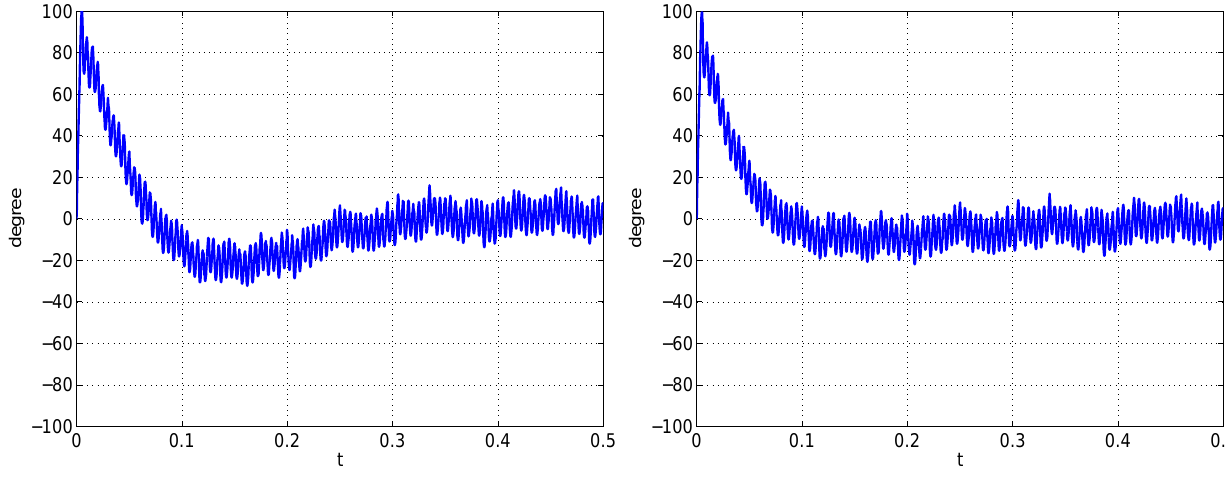
Figure 11. Phase error of Simulink simulation. Left : linear design. Right : nonlinear design.